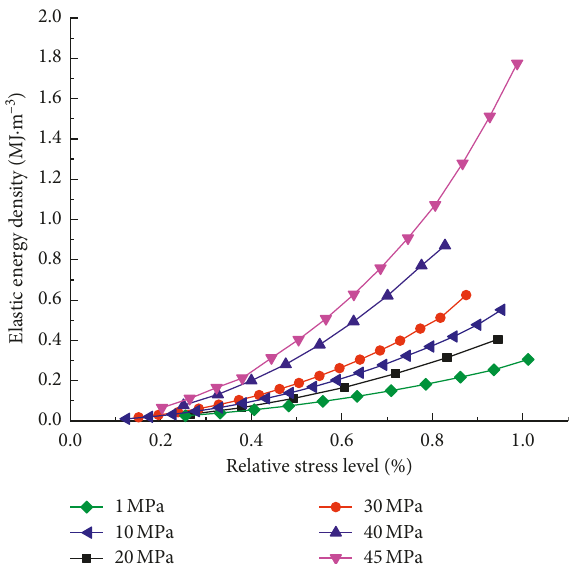
Figure 8: Elastic energy density with relative stress level.